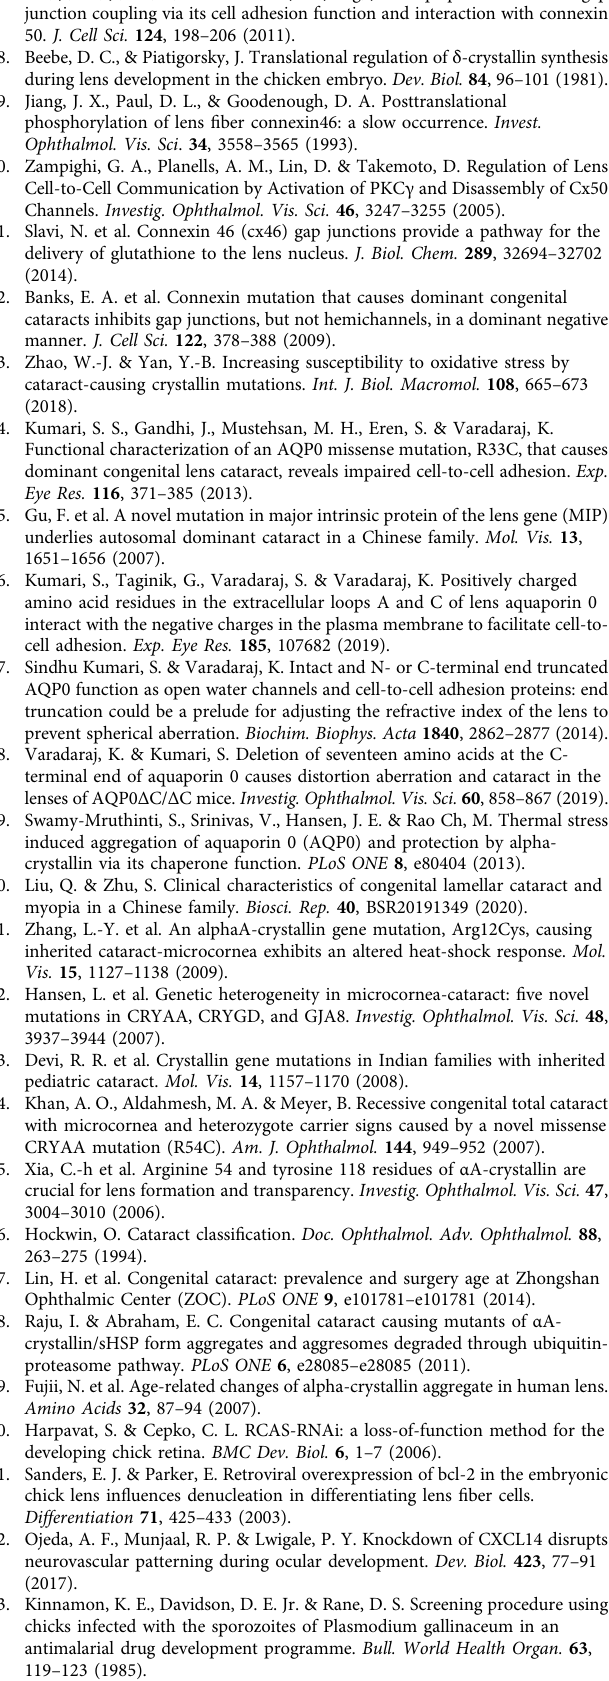
The source data for uncropped western blots and source data underlying all graphs and charts for main fi gures presented in this paper are available as Supplementary Data